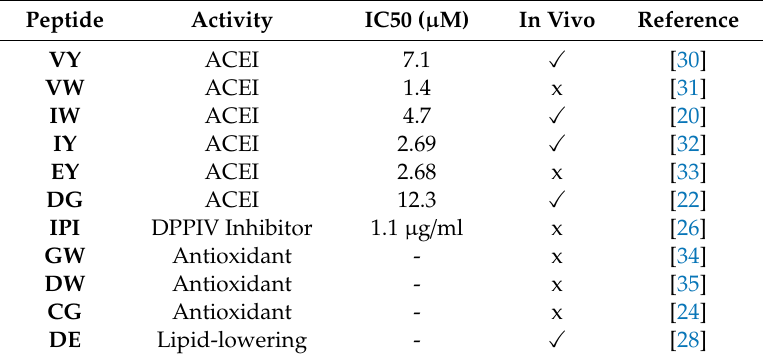
Table 1. Biopeptides selected to design a protein for metabolic syndrome